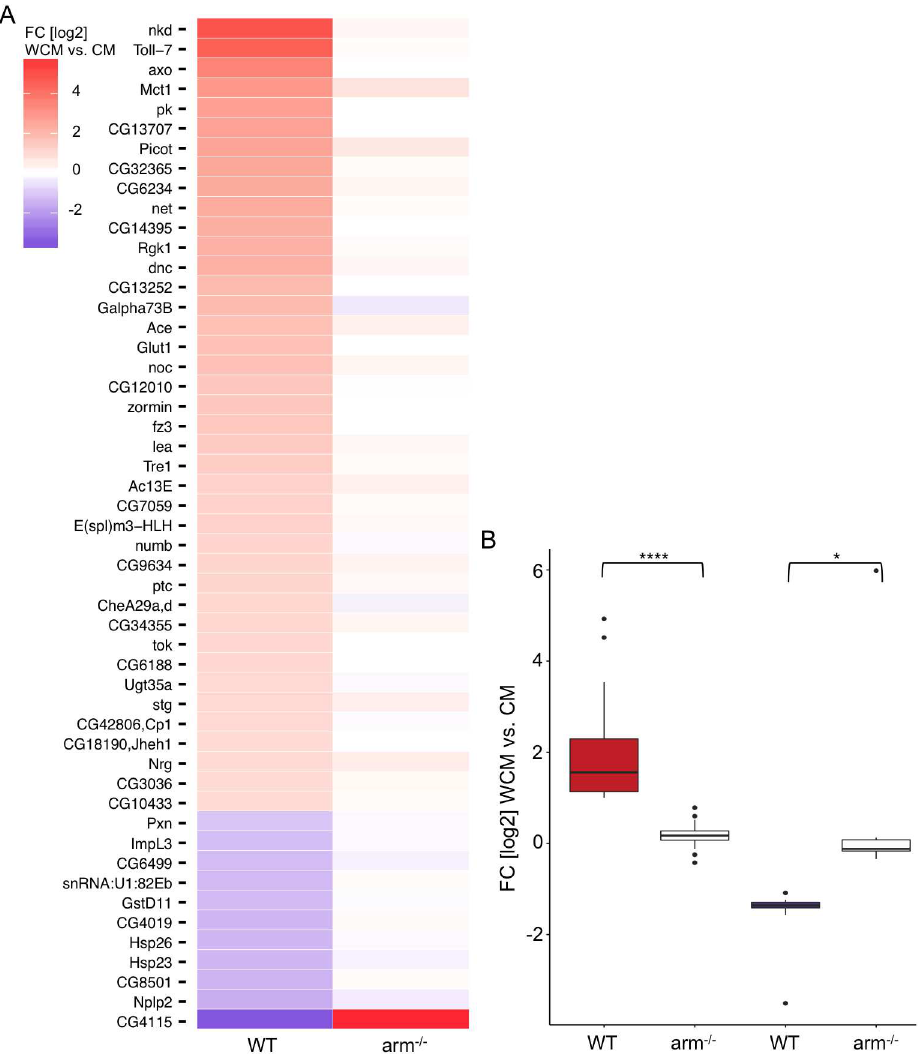
Fig 3. Gene expression analysis of Wg/Wnt target genes in arm -/–AFII7/8 cells. (A) Heat map of Wnt/Wg target genesshowingtheir log2 fold change(FC) of expressionafter to before WCM treatment in wild-type (WT) and arm -/–AFII7/8 (arm -/- ) cells. The genes are listed accordingto the strength of the inductionof their expressionin WT cells. Strongest up-regulated genesare on top. Up-regulatedgenesare shown in red, down-regulatedgenes in blue, no expressionin white. (B) Boxplots showingthe difference in gene activity for up- and down-regulatedgenes after WCM stimulationin wild-type(WT) and arm -/–AFII7/8 (arm -/- ) cells. Paired t-test: * (cid:20) 0.05, *** (cid:20) 0.0001.